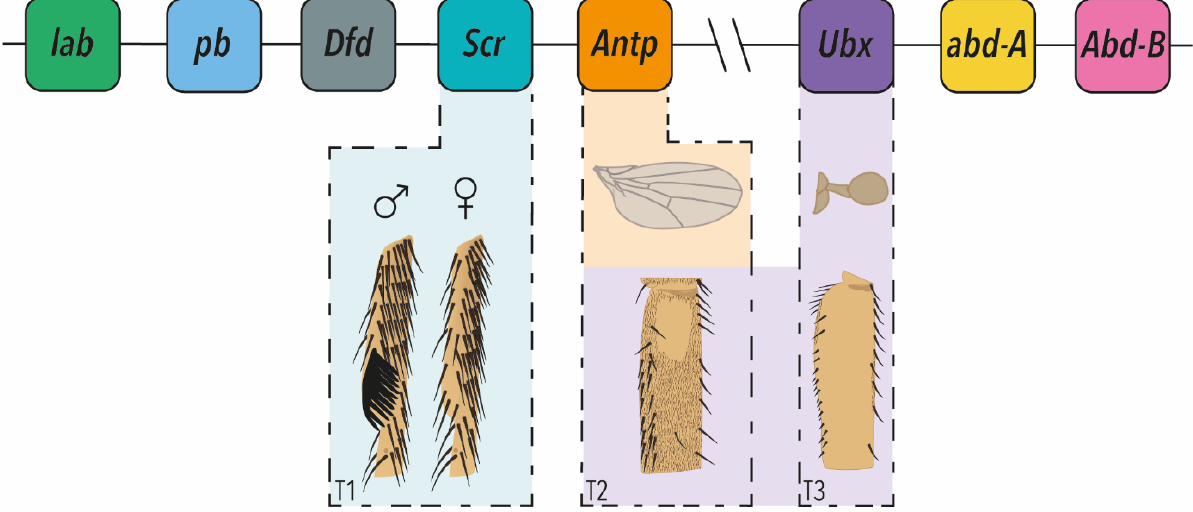
Figure 1. The Hox clusters of Drosophila melanogaster and micromanagement of appendage morphol- ogy. The Antennapedia and Bithorax clusters are shown above drawings of T1, T2 and T3 appendages whose morphology is managed by the Hox genes indicated. Males exhibit modified bristles called sex combs on T1, which is regulated by Scr . T2 wing morphology is regulated by Antp . T2 legs exhibit a Ubx -dependent variably sized trichome-free patch of cuticle on the proximal posterior femurs. On T3, the hind-wings have evolved into halteres, which are specialised balancing organs. This is achieved through Ubx repression of wing development, and promotion and fine-scale sculpting of haltere development. Ubx also modulates the morphology of the T2 and T3 legs.